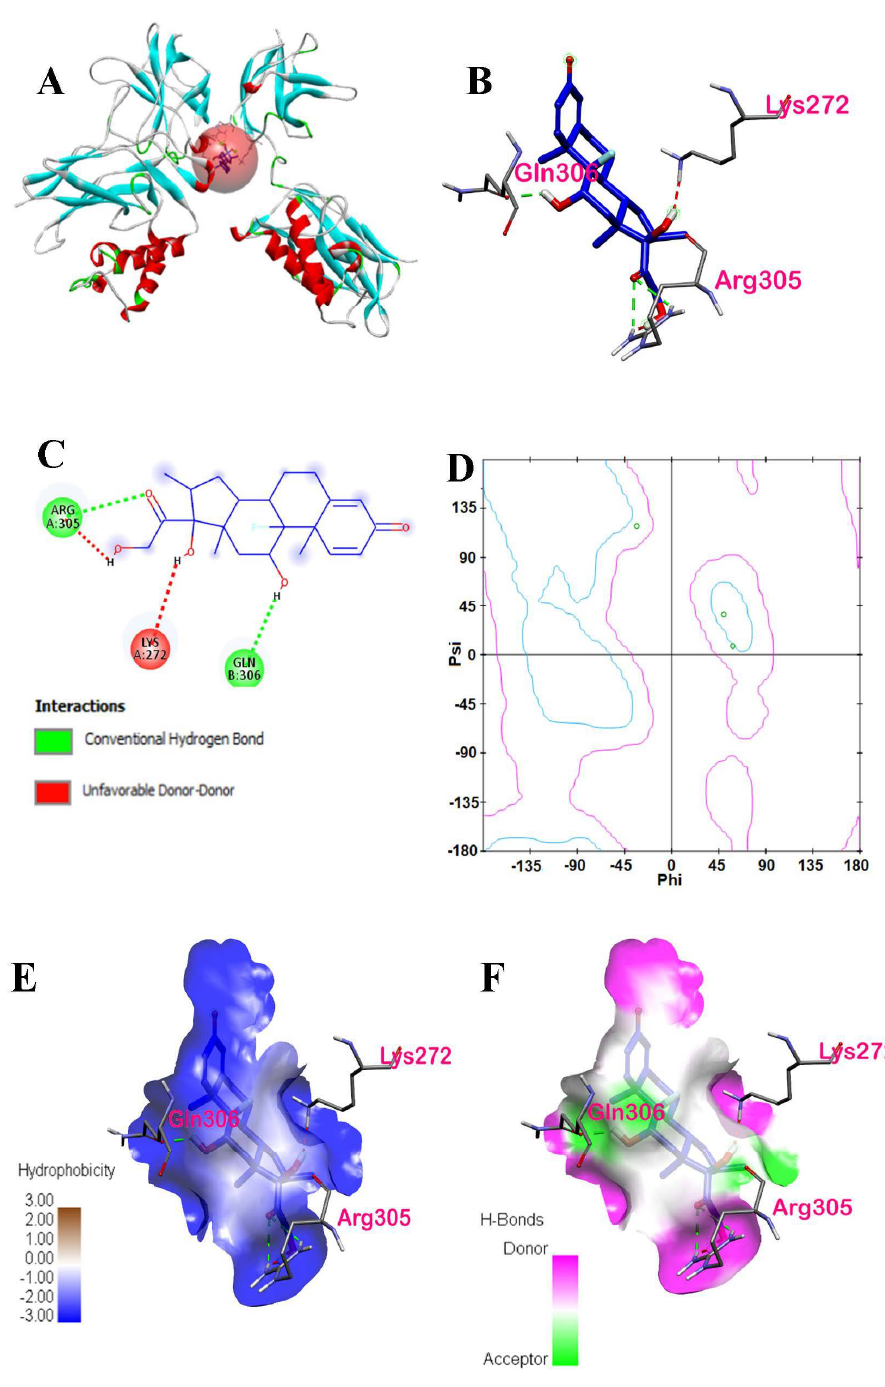
Figure 13. Binding interactions of dexamethasone and p50 subunit in the NF − κ B dimer: ( A ) three dimensional visualization of dexamethasone docked at p50 with defined binding site represented by a red sphere, ( B ) three-dimensional interaction of dexamethasone and interacting amino acids of p50, ( C ) two-dimensional diagram visualization of dexamethasone − p50 protein complex, ( D ) Ramachan- dran plot of ligand-interacting amino acid residues, ( E ) hydrophobic interactions of ligand-interacting amino acid residues, and ( F ) hydrogen bonding of